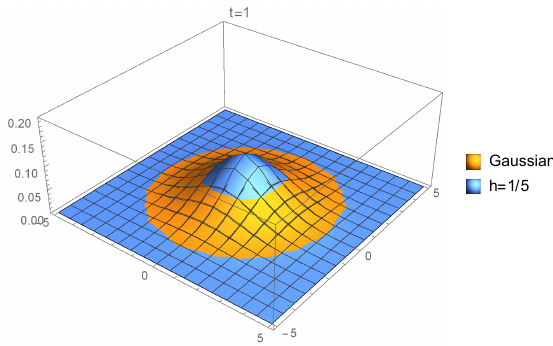
Figure 4. Comparison of G n , h with G 1 as h